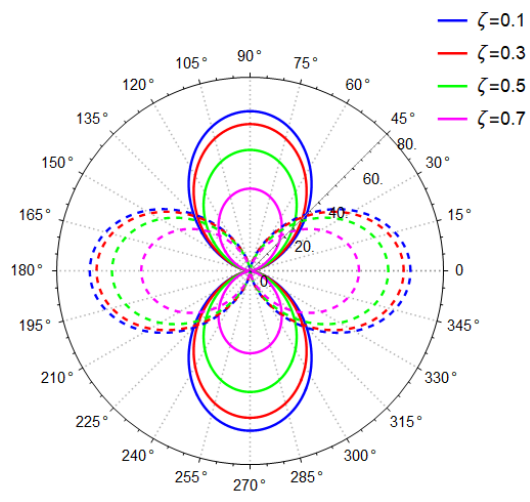
Figure 1: Polar dependence of the residue of the longitudinal conductivity σ xx for Drude like pole ω (solid lines) and spacetime pole ω 1 [ meV. τ 2 ] − 1 . The structure of spacetime is such that the new pole ω imp a parent Drude pole ω in the sense that the sum of their intensities has a well defined 1 ζ → 0 limits. The polar angle is measured from the direction of the tilt vector ζ